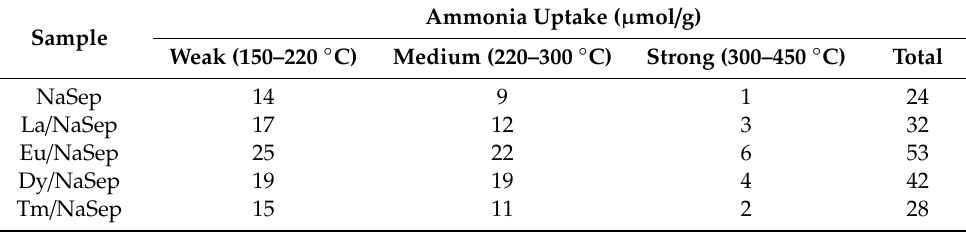
Table 3. Ammonia uptakes of the samples.